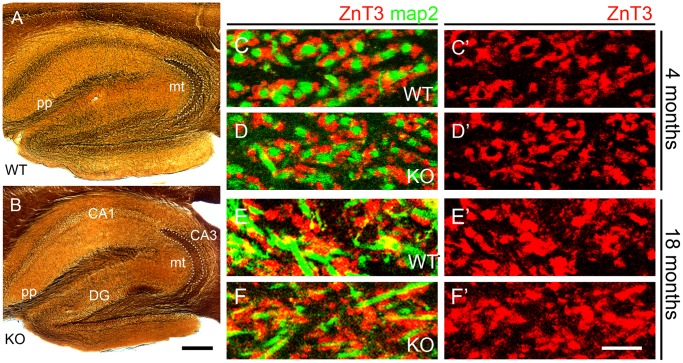
Absence of visible changes in hippocampal circuitry in Polµ−/− mice.(A, B) Silver staining shows perforant path axons (pp) and mossy fibers forming axon terminals (mt) in the stratum lucidum of CA3 (outlined), in 4-months-old mice. The images do not suggest anatomical differences between wild-type (A) and Polµ−/− (KO) mice (B). (C – F’) Mossy fiber terminals in CA3 stratum lucidum immunostained for ZnT3 in wild-type (C, E) and Polµ−/− (D, F) mice, at 4 months (C, D) and 18 months (E, F); map2 immunostaining reveals dendrites of CA3 pyramidal cells. The distribution of the ZnT3+ mossy fiber expansions was altered with aging, but no differences occurred between wild-type and Polµ−/− (KO) mice of each age. CA1, CA3, areas of the hippocampus proper; DG, dentate gyrus; mt, mossy fiber expansions; pp, perforant pathway. Scale bar, A, B: 250 µm; C–F’: 10 µm.